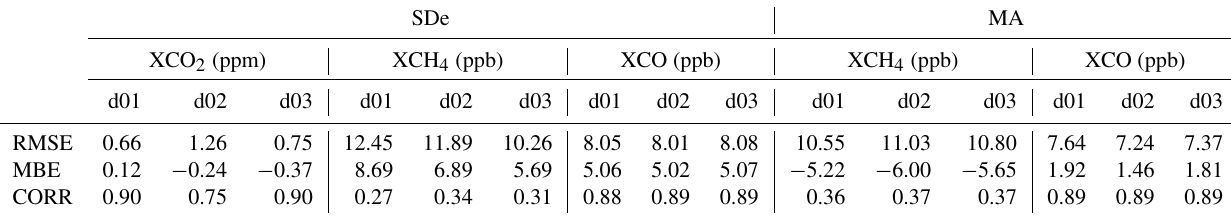
Table 4. Overview of WRF-GHG performance of simulating hourly FTIR observations of GHG at Réunion Island, for all model domains. Comparison with the column observations is done using the smoothed model